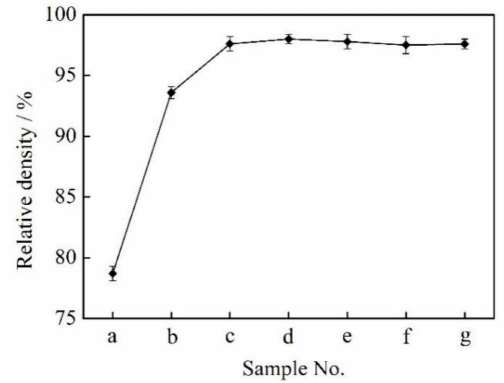
Figure 3. Relative density of W-6Ni-4Co alloys by the di ff erent sintering processes: ( a ) 1200 ◦ C, 30 min; ( b ) 1450 ◦ C, 5 min; ( c ) 1450 ◦ C, 20 min; ( d ) 1450 ◦ C, 60 min; ( e ) 1500 ◦ C, 5 min; ( f ) 1500 ◦ C, 20 min; ( g ) 1500 ◦ C, 60